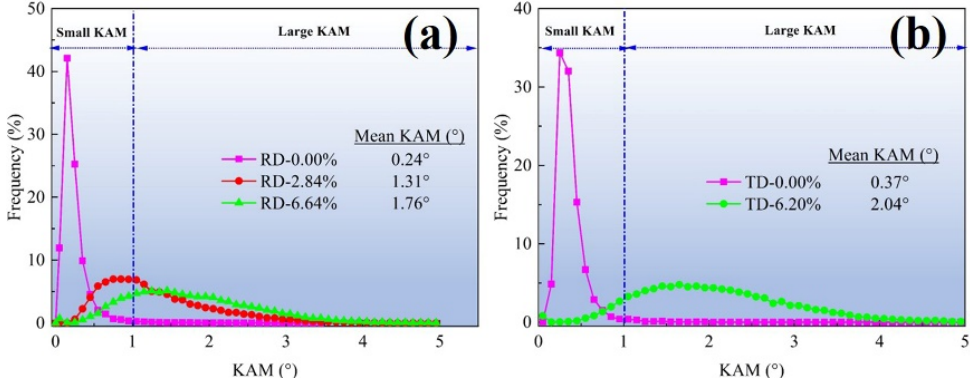
Figure 6. KAM distribution of Zircaloy-4 under various strains, ( a ) along RD, ( b ) along TD.